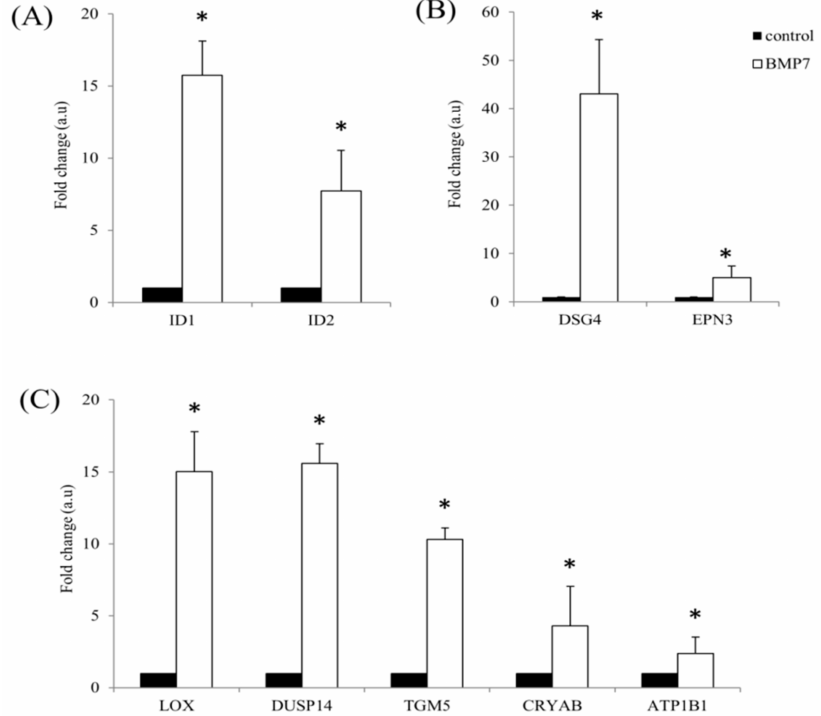
Figure 3. Validation of the Clariom ™ S array identified differentially expressed transcripts. hTCEpi cells were cultured in the presence of 100 ng/mL BMP7 and RNA was isolated after 24 h. Reverse transcription was performed using 1 µ g of total RNA to prepare cDNA and qRT-PCR was performed to find differentially expressed transcripts using respective primers. ( A ) ID proteins (ID1 and ID2); ( B ) cytoskeletal proteins (DSG4 and EPN3); and ( C ) metabolic enzymes (LOX, DUSP14, TGM5, CRYAB, and ATP1B1) differential expression was analyzed using respective primers. Relative expression pattern was analyzed by the comparative threshold cycle (2 − ∆∆ C t ) method. Expression values were represented as fold change over the control on an arbitrary scale after normalization with GAPDH. Data represent mean ± standard deviation of three independent experiments. p -values of <0.05 were considered statistically significant and are indicated by asterisks